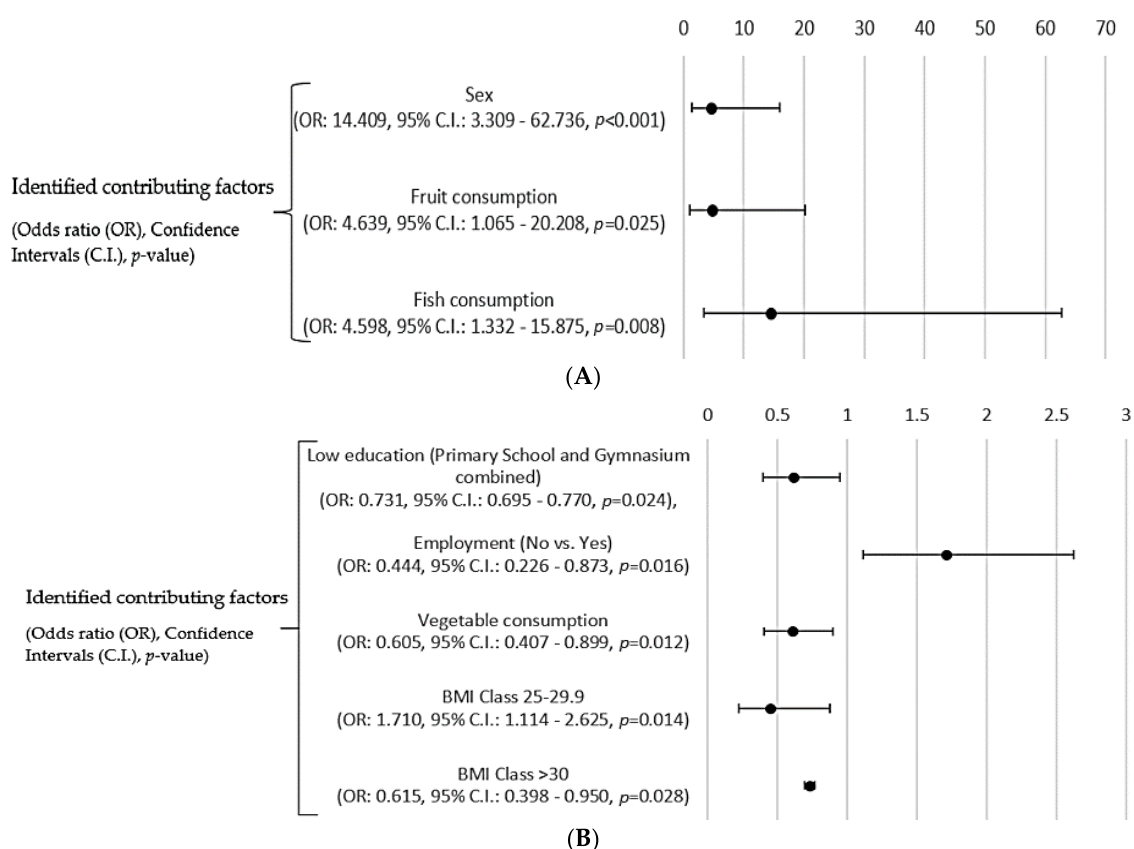
Figure 5. ( A ): Odds Ratio outcomes regarding the common use of MAPs, ( B ): Odds Ratio outcomes regarding the use of MAPs in symptoms and common health